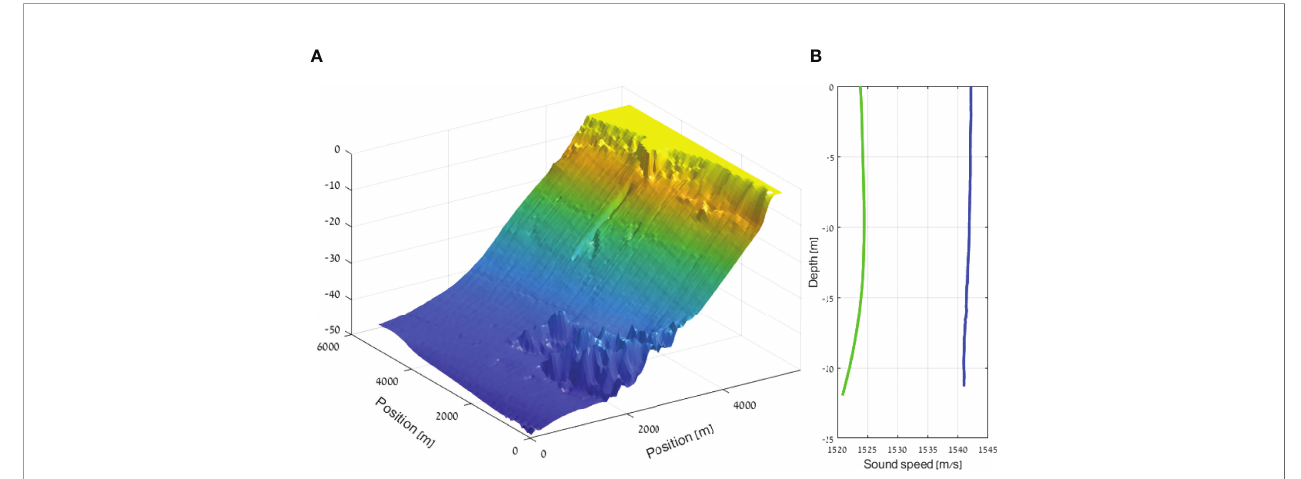
FIGURE 2 | (A) Bathymetry, (B) eastern Mediterranean winter SV, SVP H (blue) measured sea experiment SVP M (green) of the area near “ Orot Rabin ” Power and Desalination Station in Hadera,